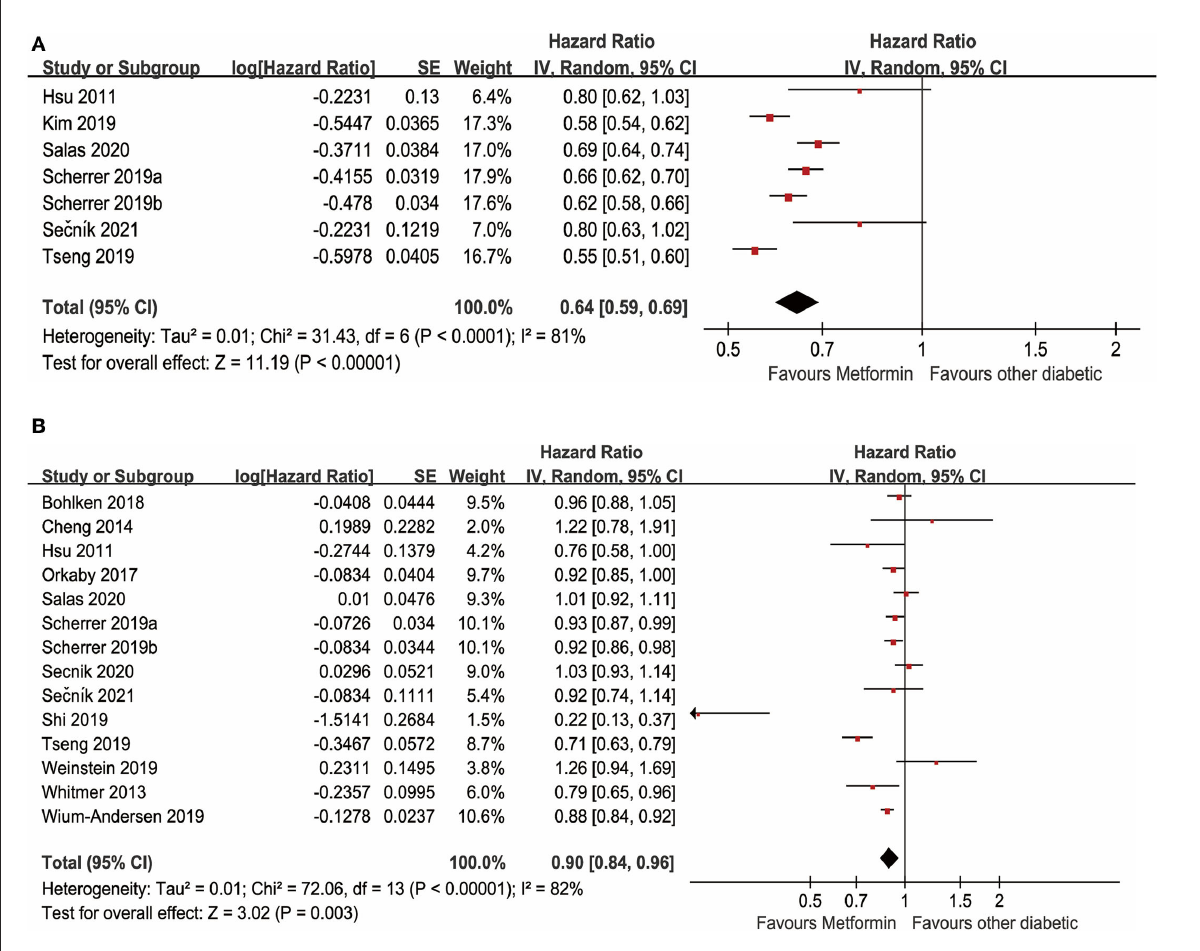
FIGURE3 (A) Meta-analysis of unadjusted covariates between metformin and the occurrence of dementia. (B) Meta-analysis of adjusted covariates between metformin and the occurrence of